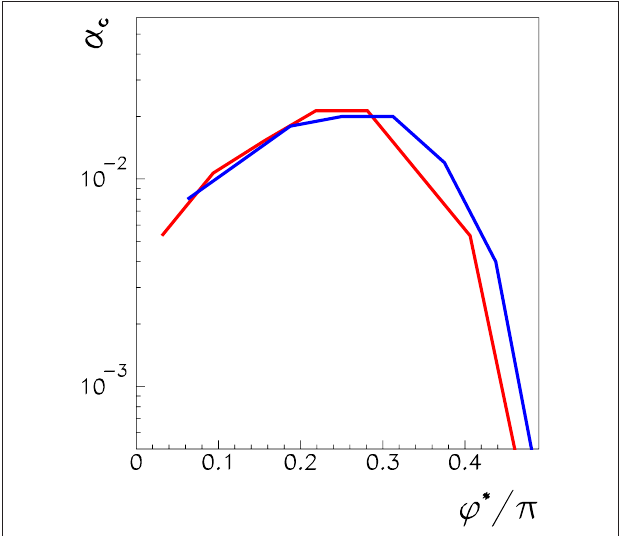
Figure 3 | Maximum capacity α = P / N of a network of N = 3000 (red) c max and N = 6000 (blue) fully connected analog neurons, as a function of the learning window asymmetry ϕ * . The limit ϕ * = 0 corresponds to a symmetric learning window ( J ) that is to output frequency ω /2 π that − J ij ji tends to zero. The limit ϕ * = π /2 corresponds instead to a perfectly anti- symmetric learning window, and output frequency ω /2 π = ∞ . The intermediate value ϕ * 0.25 π gives the best performance of the 